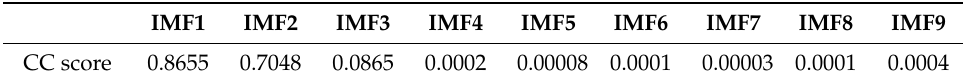
Table 2. Correlation coe ffi cients between the first nine intrinsic mode functions (IMFs) and the original signal.